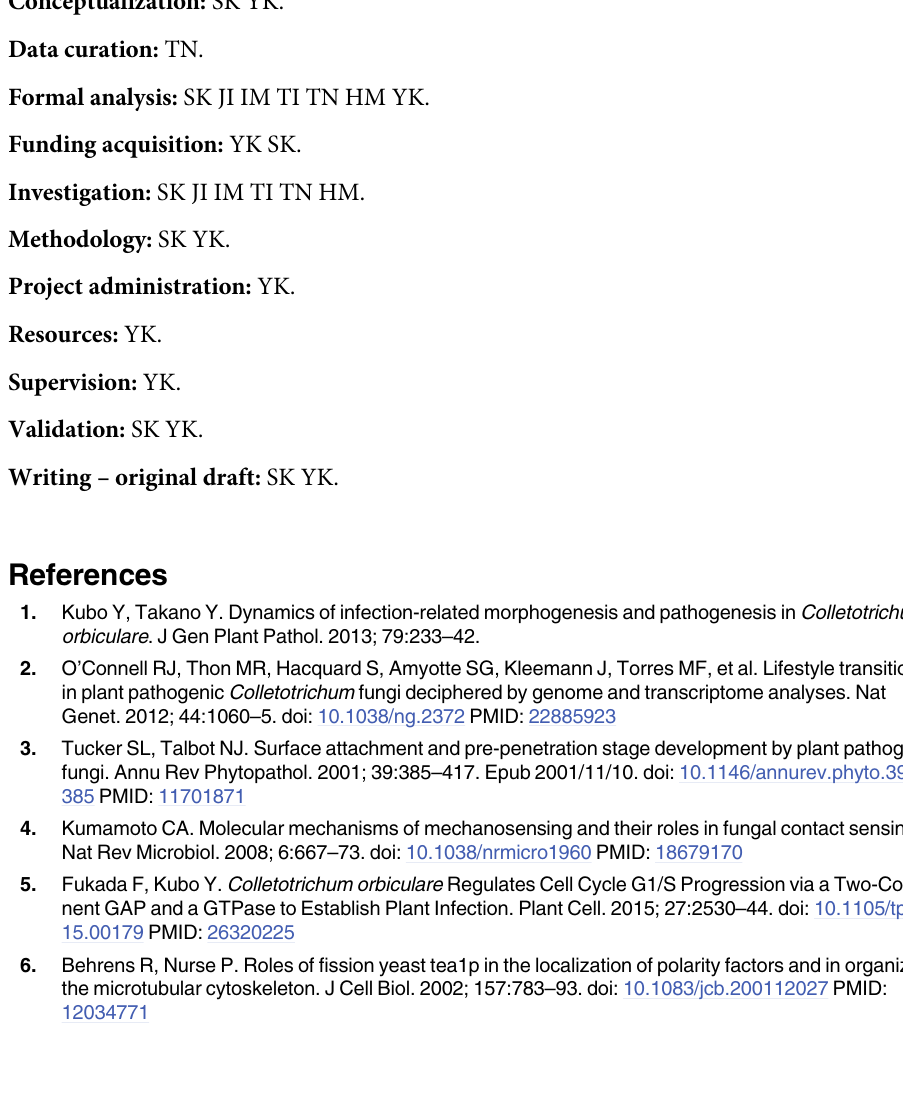
S4 Table. PCR primers used in this study. (PDF) S1 Data Set. Differentially regulated genes in strain CoCbk1-CA in the copag1 Δ mutant background compared with the wild type during appressorium development in vitro .